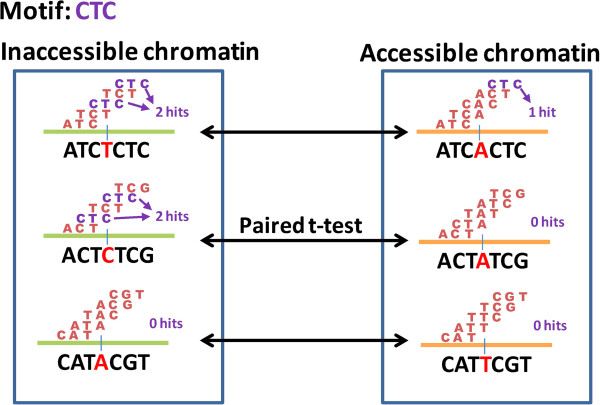
An example motif CTC. Assume that a motif candidate is the sequence CTC. We calculated the number of hits (frequency of sequences) among all sliding windows for each DCSR. The frequency vectors of the inaccessible and accessible chromatin groups are [2, 2, 0] and [1, 0, 0], respectively. Next, we performed a paired t-test between these two frequency vectors to determine the significance of this motif in terms of differential chromatin states.